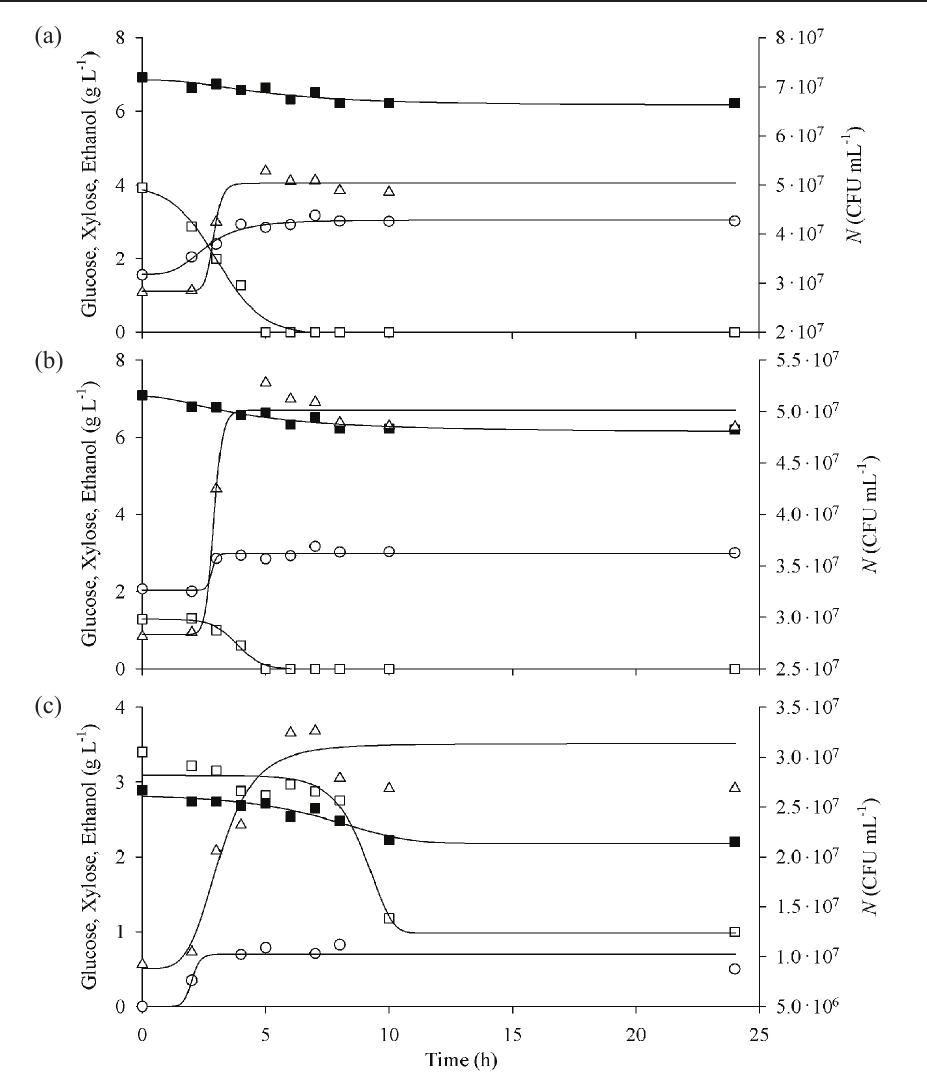
Fig. 6 – Changes in glucose (□), xylose (  ), ethanol (○), and cell number (N, ∆) con - centrations during anaerobic cultivation of genetically engineered S. cerevisiae on differ- ent liquor wheat straw hydrolysate media: 160 °C/10 min/2 % w/w H straw/180 °C/10 min/2.0 % w/w H